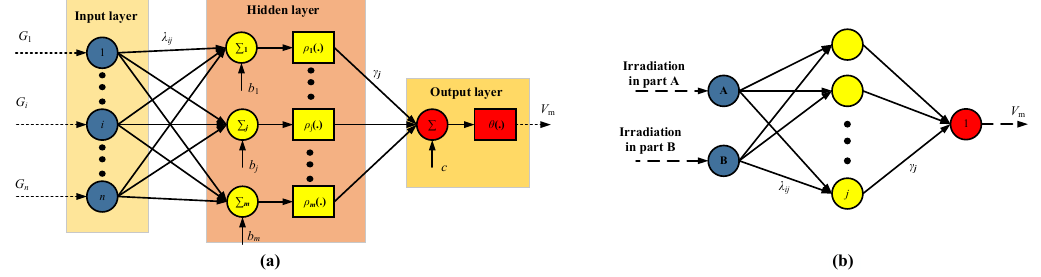
Figure 4. Structure of ANN in MPPT: ( a ) Typical ANN structure; ( b ) ANN structure proposed in this paper.